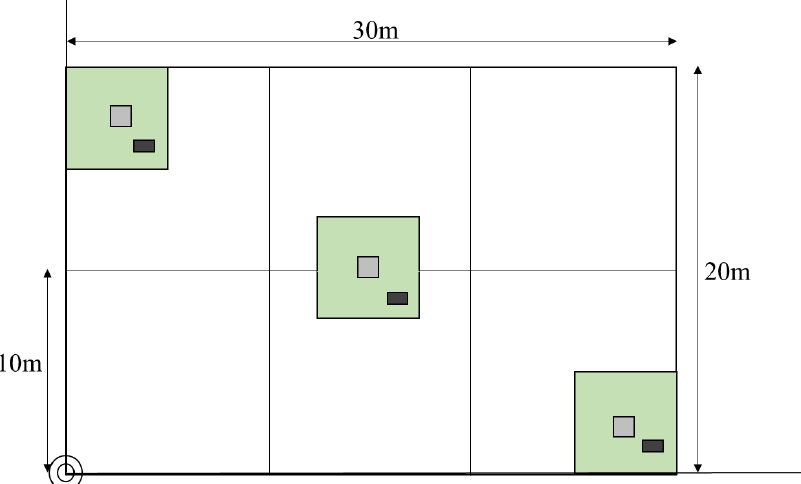
Figure 6. Survey units for trees, shrubs, herbs, and soils. All trees in the plots with a diameter at breast height (DBH) larger than 5 cm were investigated. Starting from the lower-left corner of each plot, trees in the plot were num- bered according to an “S” shape. For each tree, the tree species, tree height (m), DBH (cm) and position were recorded. The species, number, height (m), and coverage of shrubs (%) and herbs in each plot were recorded. The surveyed information of the plots also included altitude (m), terrain, slope ( ◦ ), position, aspect, and soil